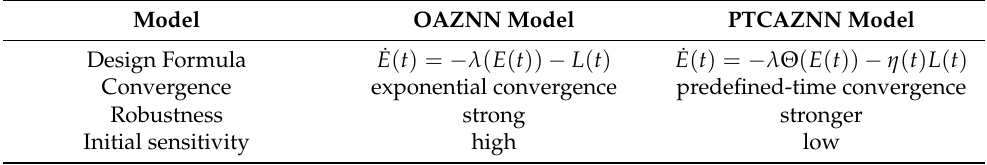
Table 1. Comparison of OAZNN (11) and PTCAZNN (15) for time-variant matrix inversion.